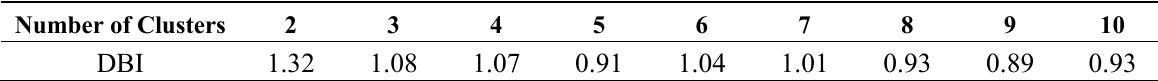
Table 4. Davies-Bouldin index (DBI) of k-means clustering at different number of clusters on the trained